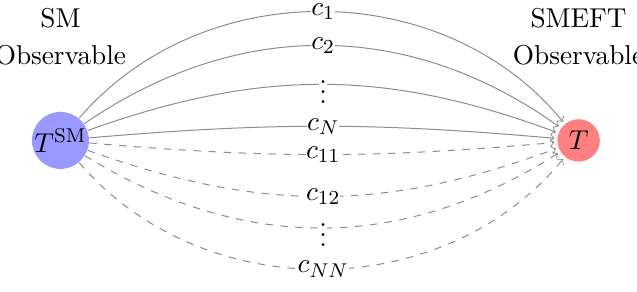
Figure 3 . Schematic representation of how SIMUnet allows for the effects of the SMEFT self- interaction diagrams (dim-6) 2 to be included. We show here how the SM observable can be trans- formed to a SMEFT observable which includes these O (1 /v 4 ) terms. The preceding PDF layers are omitted for clarity. The linear contributions are included in the usual way, with the strength of the SMEFT couplings being determined by the trainable edges, c n : shown by the solid lines. The SMEFT-SMEFT interference contributions are instead non-trainable edges with their value being fixed by the strength of the corresponding pair of trainable edges. These are shown by the dashed lines. There will in general be N trainable edges, and N ( N + 1) / 2 non-trainable